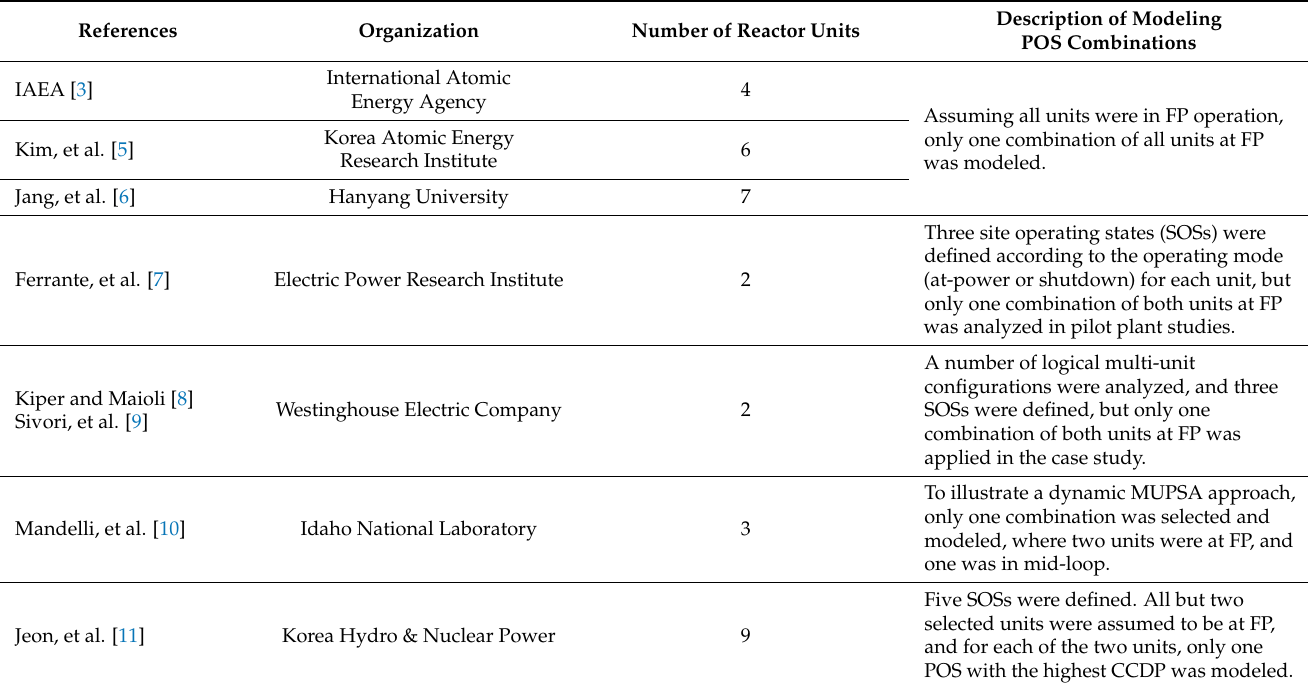
Table 1. Summary of recent studies on